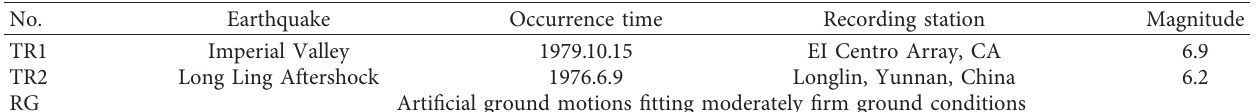
Table 4: Ground motion records.